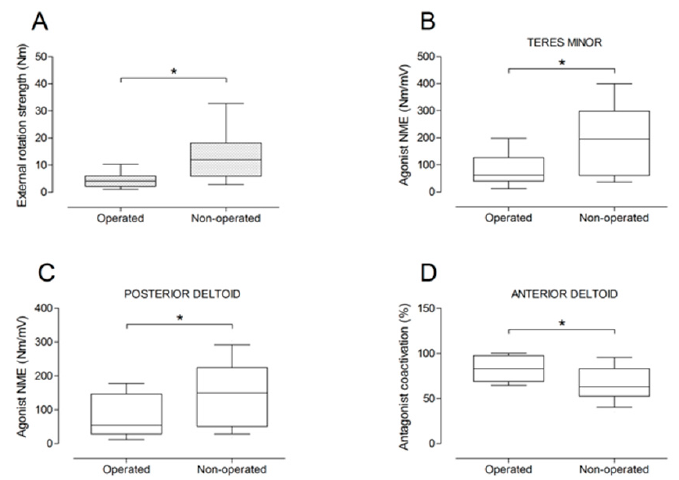
Figure 9. Box and whisker plots of shoulder external rotation strength ( A ), agonist neuromuscular efficiency (NME) of teres minor ( B ) and posterior deltoid ( C ) muscles, and antagonist coactivation of anterior deltoid muscle ( D ). The horizontal line in the box represents the median, the height of the box represents the interquartile range, and the distance between the opposite ends of the whisker represents the 10th–90th percentile. * Operated (cid:44) non-operated ( p < 0.05). The distance “m” from COR consistently increased post-operatively (from 20.9 ± 3.3 mm to 36.2 ± 4.0 mm; p < 0.001) with a mean COR medialization of 15.3 ± 3.7 mm. Humerus length was longer on the operated (327 ± 21 mm) than on the non-operated side (321 ± 18 mm) with a mean humerus lengthening of 5.6 ± 7.7 mm ( p = 0.011). No significant correlation was found between COR medialization and humerus lengthening ( p > 0.05). Very large correlation coe ffi cients were observed between shoulder adductor strength asymmetry and both COR medialization (r = − 0.732; p < 0.001; Figure 10A) and humerus lengthening (r = 0.705; p < 0.001; Figure 10B). For all the other muscle groups, no significant correlations were observed between radiographic findings and strength